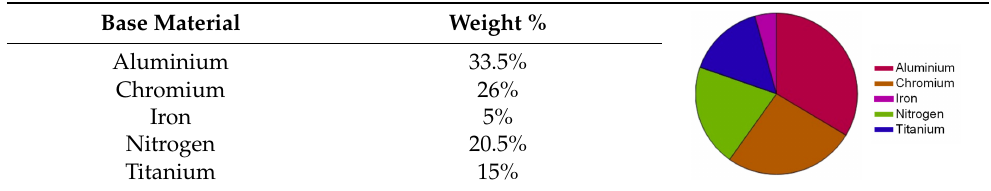
Figure 3. Tool wear.